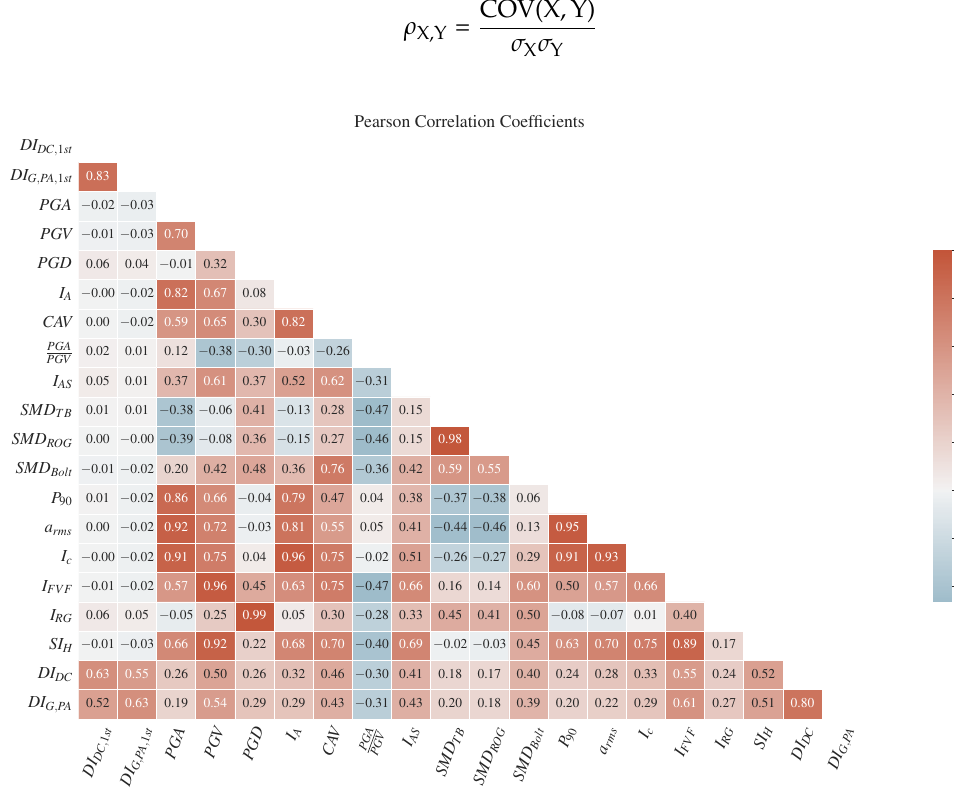
Figure 6. Heatmap of Pearson’s correlation coefficient for every pair of the examined variables including input features and